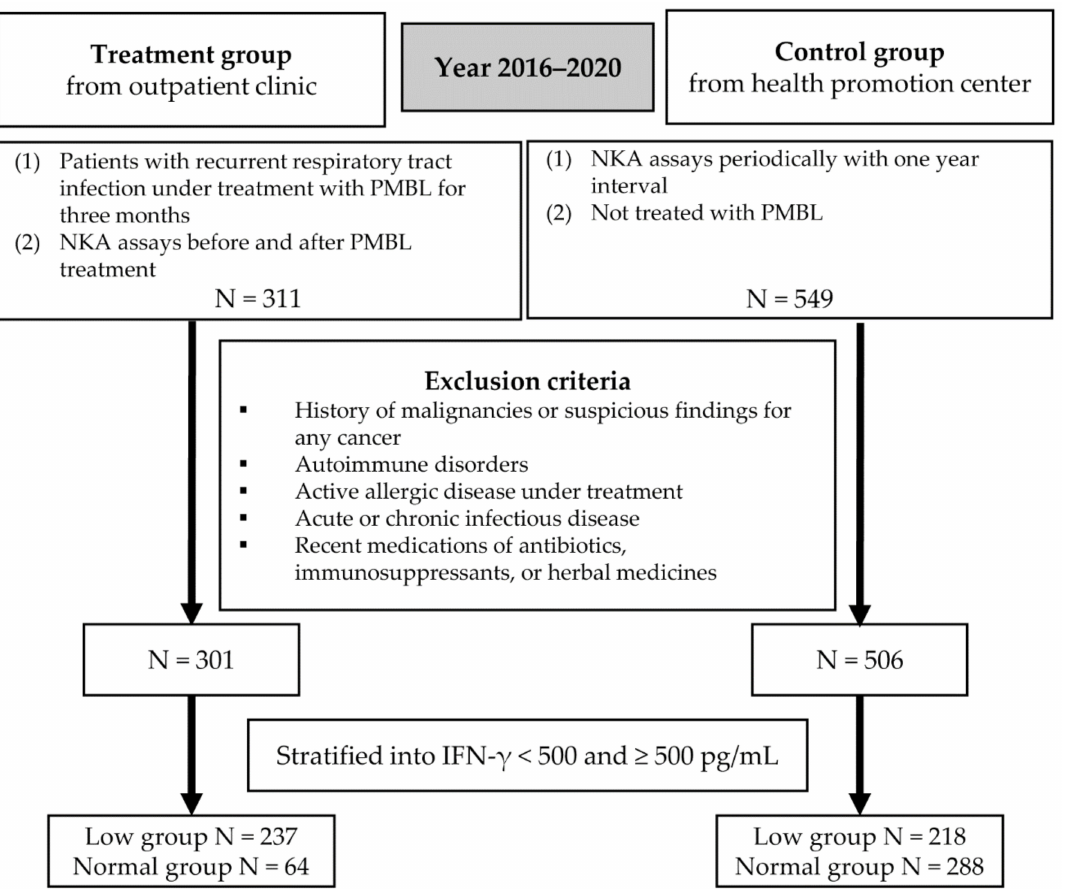
Figure 1. The flowchart of the study. PMBL, polyvalent mechanical bacterial lysate; NKA, natural killer cell